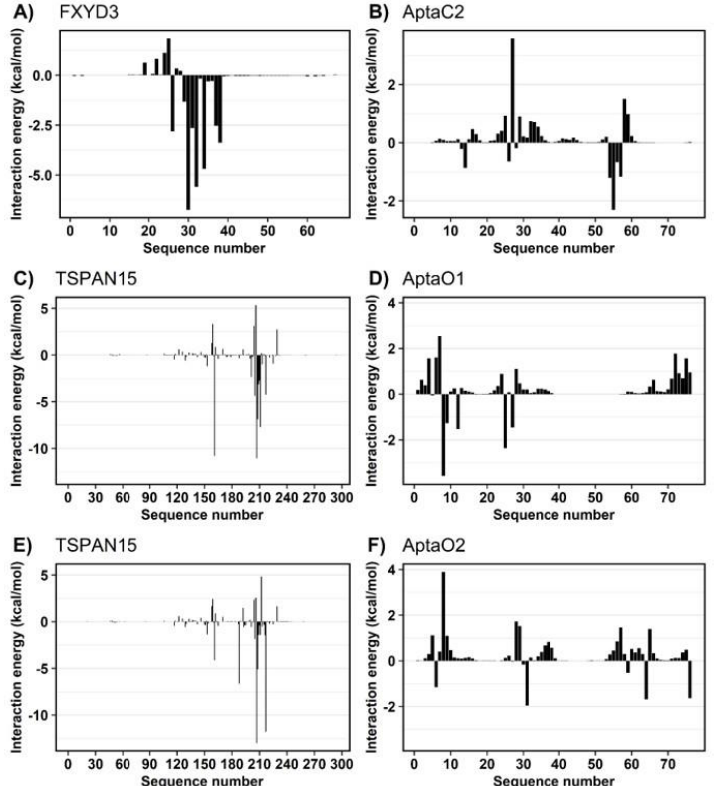
Figure 11. Decomposition of the binding free energy for the three simulated systems.